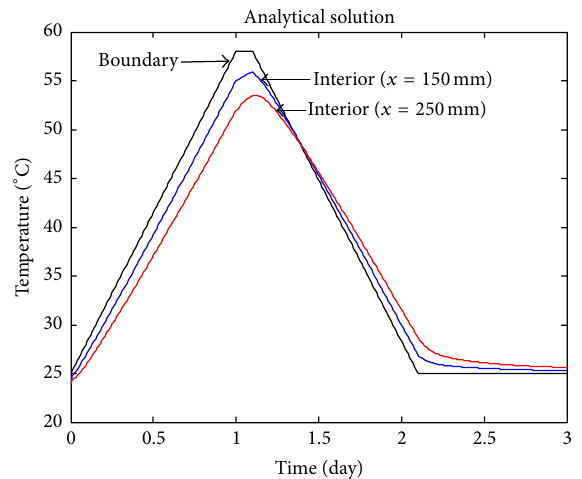
Figure 5: The interior temperatures calculated by the analytical solution (at 𝑥 = 150 mm and 𝑥 = 250